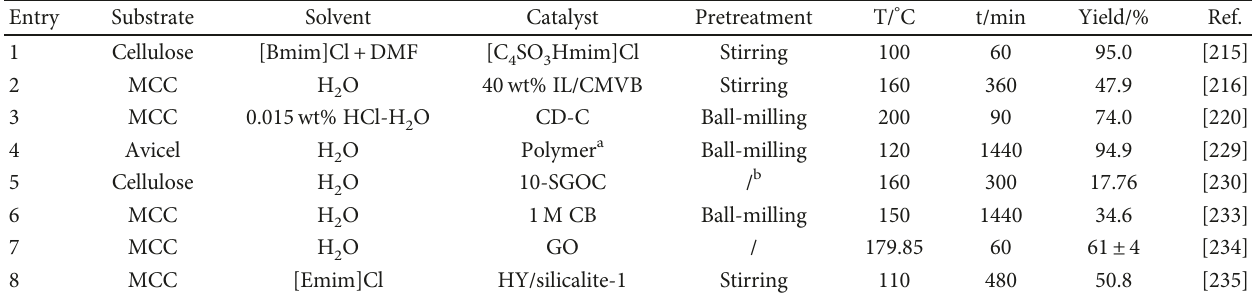
Table 2: Overview of glucose yields from the hydrolysis of cellulose in the typical catalytic system.